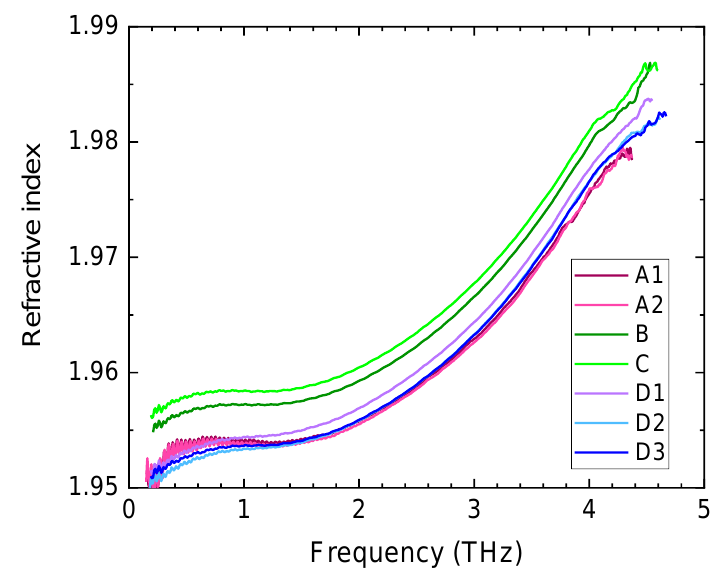
Figure 7. Refractive indices of Spectrosil 2000 silica glass samples.